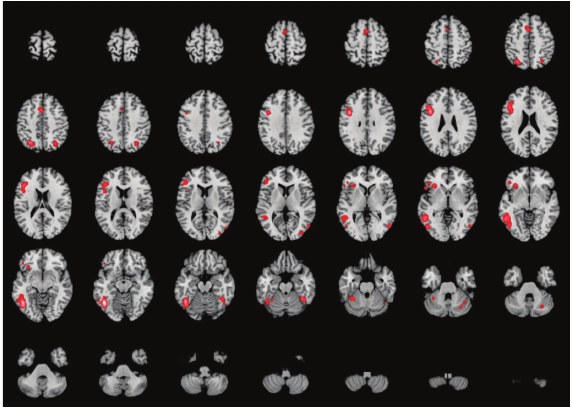
Figure 1: Language-related BA37’s network. ALE results overlaid on an axial-T1 MRI MNI-template. Left hemisphere appears in the left side of the insets (neurological convention). ALE scores are color coded from red (lower scores) to white (higher scores). In addition to the left BA37 (middle and inferior temporal gyri in the convexity and fusiform gyrus in the basal aspect) that has the highest intensity, the following regions appear “activated”: left inferior frontal gyrus; bilateral superior and inferior parietal lobule (intraparietal sulcus); left SMA and posterior lobe of the cerebellum. There is also small activation of the right fusiform gyrus and right temporooccipital areas.